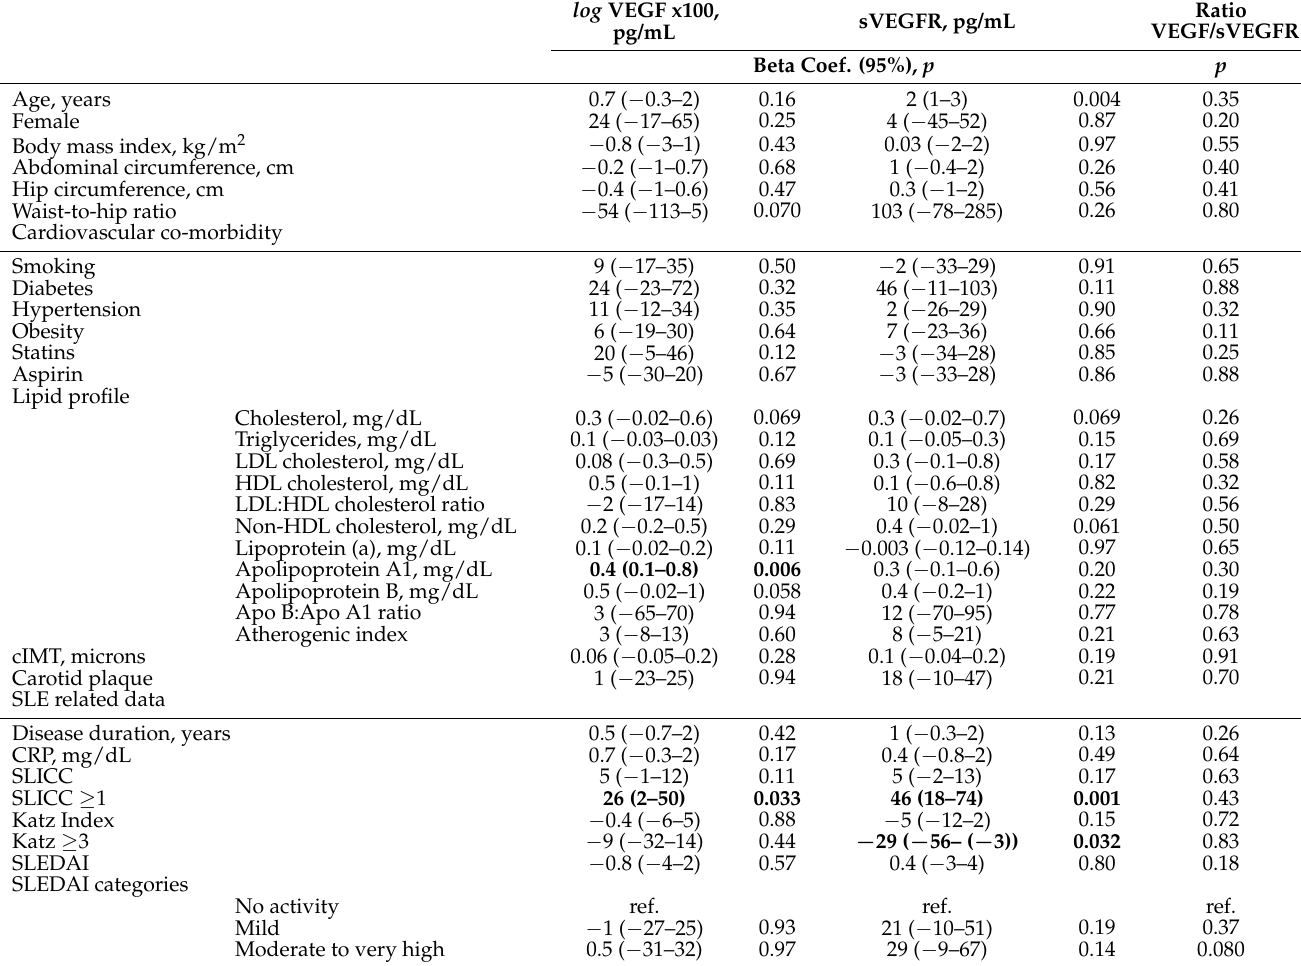
Table 2. Demographics and disease characteristics relation to VEGF and sVEGFR serum